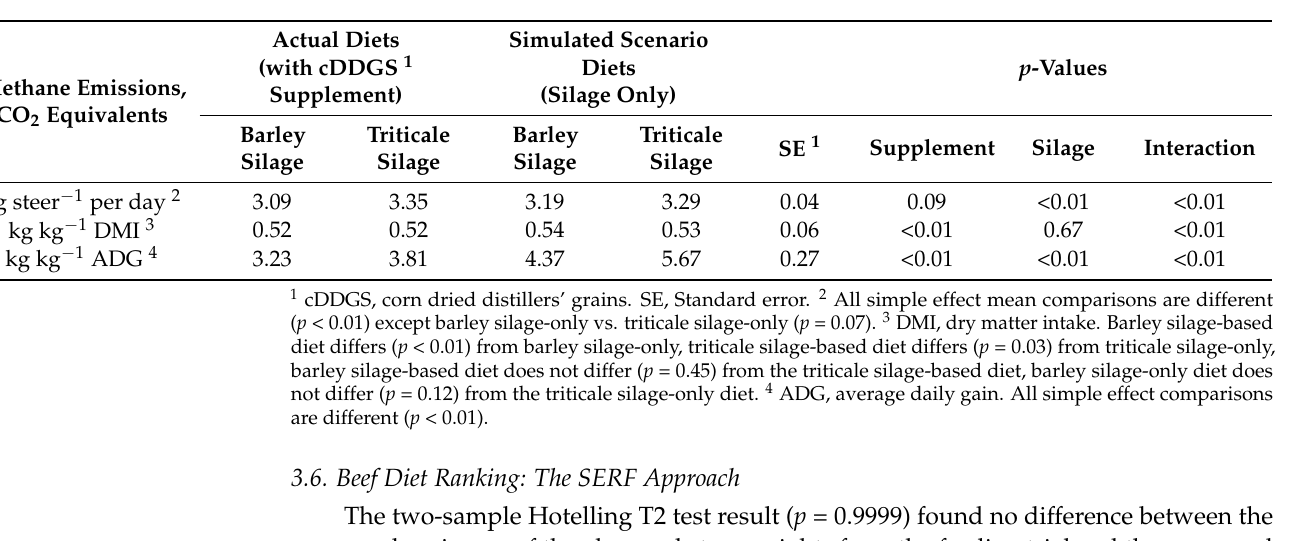
Table 5. Actual silage-based diet and simulated silage-only methane emissions